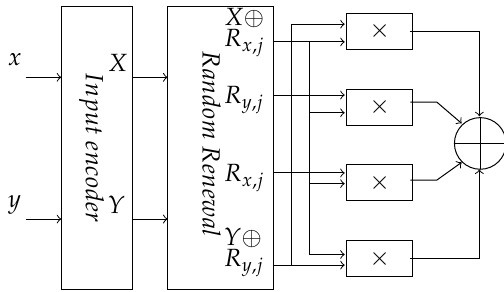
Figure 6. Secure RNS circuit with random renewal scheme.